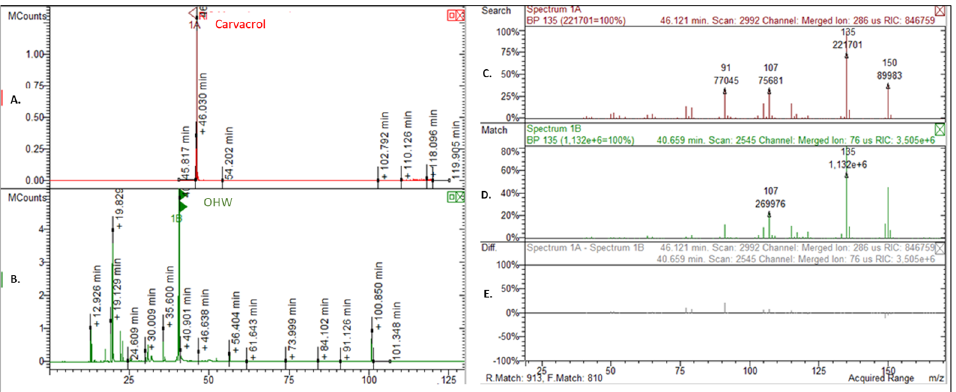
Figure 2. Example of method used for essential oils compound annotation: ( A ) standard GC chro- matogram; ( B ) essential oil GC chromatogram; ( C ) standard mass spectrum; ( D ) corresponding mass spectrum obtained in the essential oil GC chromatogram; ( E ) differences between two mass spectrum.